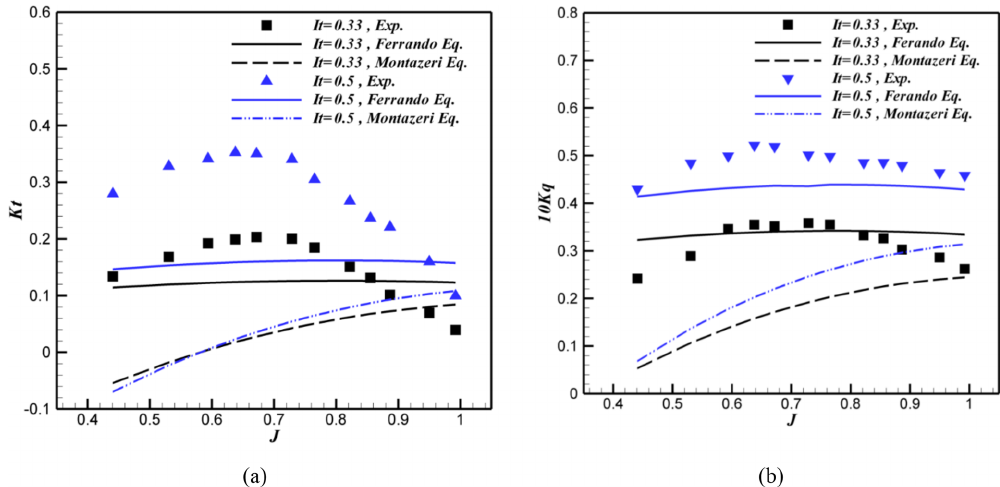
Figure 10. Comparison of the hydrodynamic coefficients predicted by Ferrando et al. (2007) and Montazeri and Ghassemi (2009) semi- experimental equations and the experimental values.